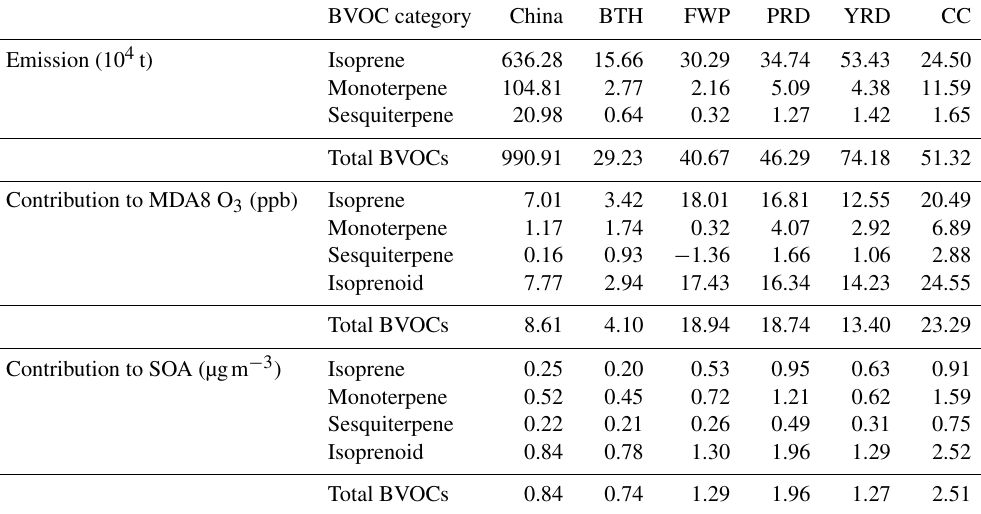
Table 2. Emissions of each BVOC category and their corresponding contribution to MDA8 O 3 and SOA concentration in the five key regions of China in June 2018.